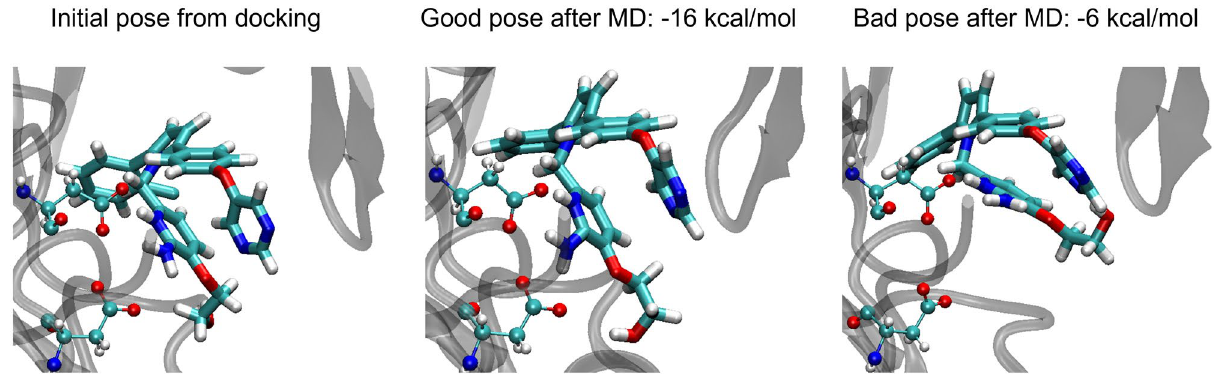
Figure 3. Initial ligand conformations from docking and for the two independent runs of BACE1 active compound CHEMBL1090542. The same initial ligand pose (left) from docking relaxes to two different conformations during the MD equilibration step. In the run that yields the more favorable BFE (middle), the ligand stays close to the initial pose, whereas in the less favorable run (right) the ligand drifts away and loses interaction with the catalytic Asp residues, resulting in much less favorable binding free energy. BACE1 is shown in ribbon representation, the two catalytic Asp residues in ball and stick representation, and the ligand in licorice